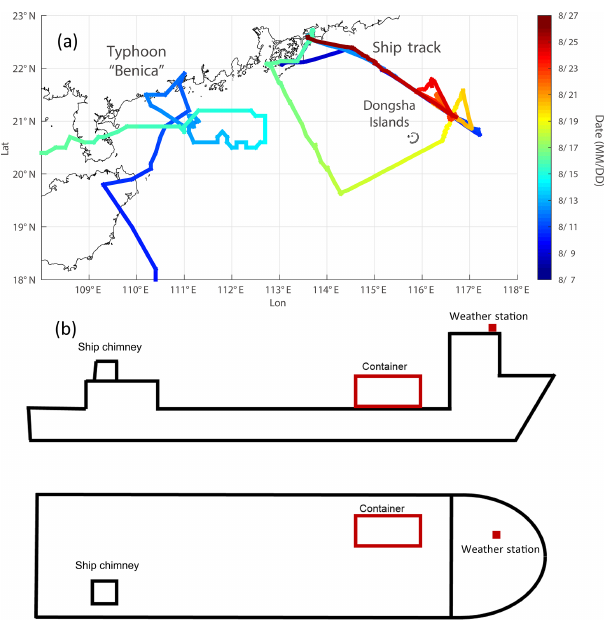
Figure 1. Ship track and tropical storm Bebinca track during the campaign (a) and schematic diagram of the vessel showing the lo- cation of the sea container which housed the onboard instruments during the campaign (b)